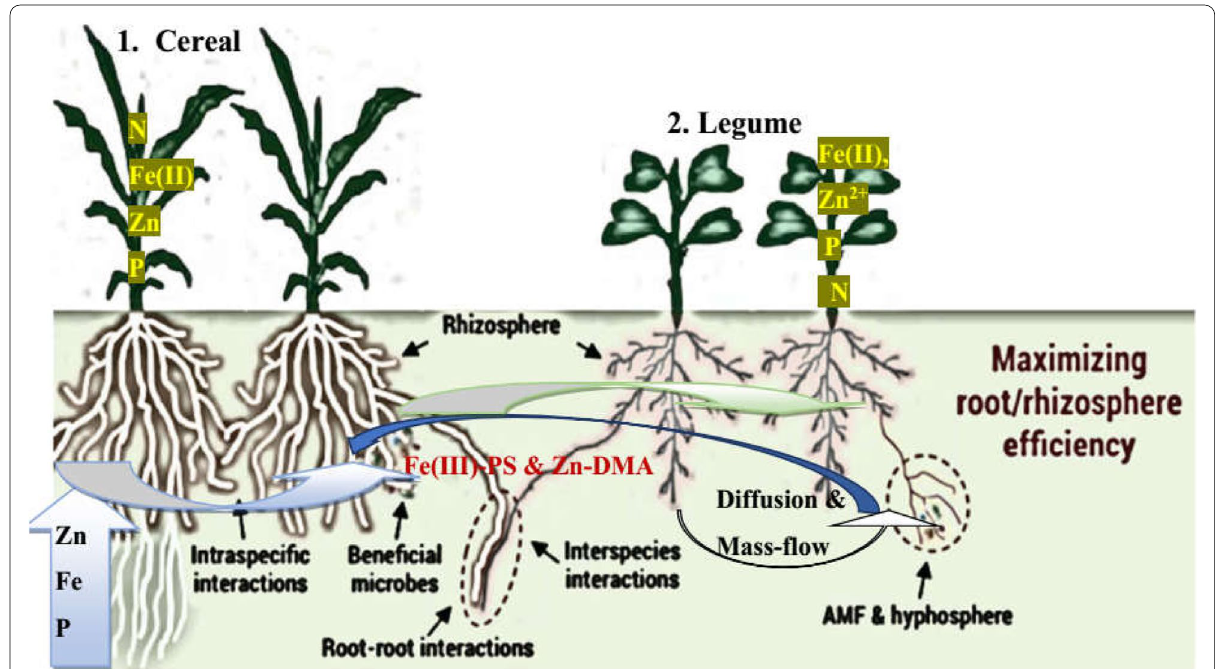
Fig. 1 Changes in rhizosphere processes in cropping systems result in higher Fe, Zn, and P availability, absorption, and translocation (modified from, (Wang and Shen